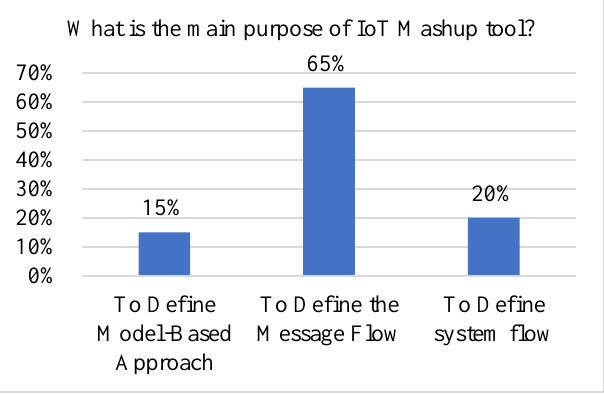
Fig. 5. Purpose of IoT mashup